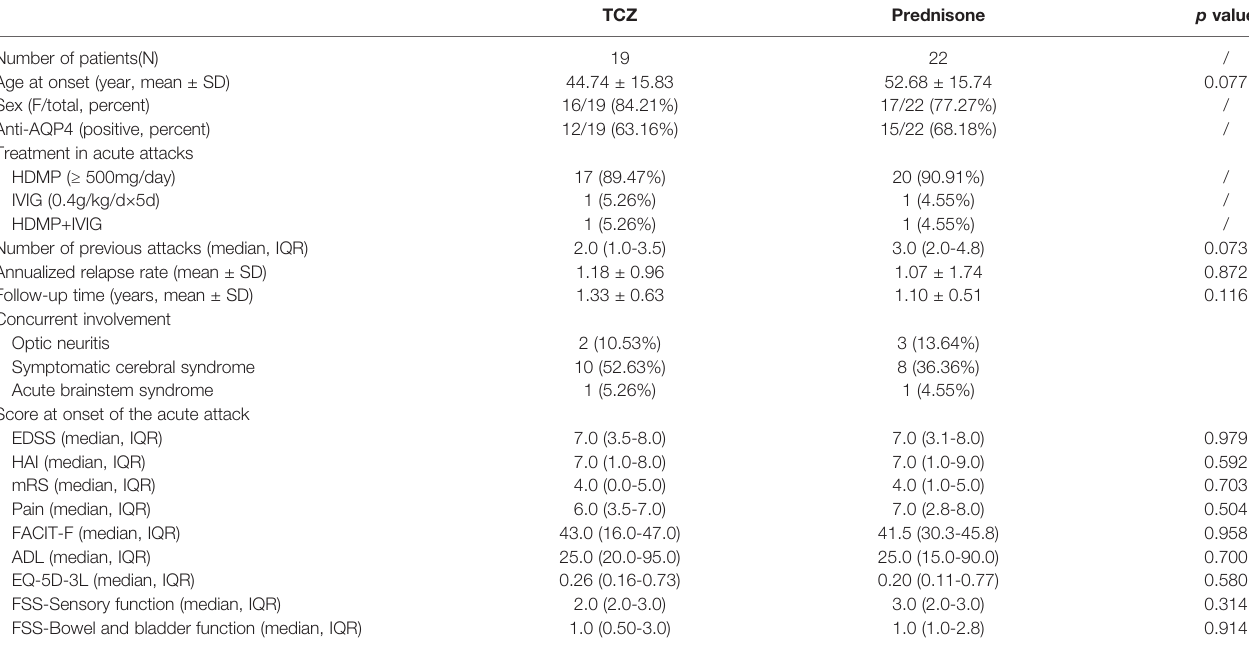
TABLE 1 | Demographics and baseline clinical characteristics of patients with longitudinally extensive transverse myelitis (LETM) in neuromyelitis optica spectrum disorder (NMOSD).